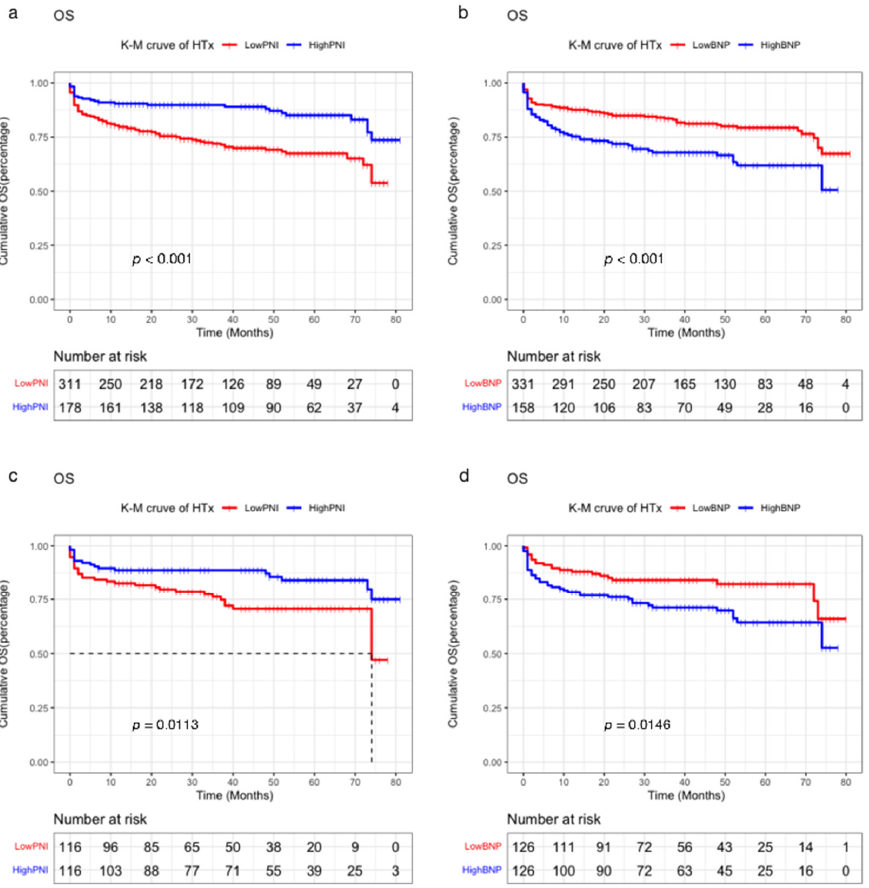
Figure 3. KM curve before and after PSM: ( a ) KM curve of PNI before PSM. ( b ) KM curve of PNI after PSM. ( c ) KM curve of BNP before PSM. ( d ) KM curve of BNP after PSM. Table 2. Univariate and multivariate analysis of overall survival in patients with heart transplanta- tion. Variables